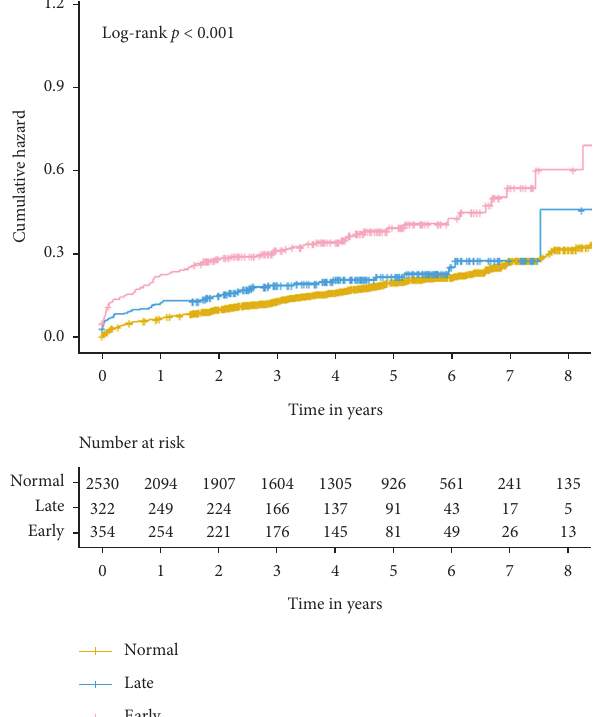
Figure 2: Kaplan–Meier curves for the cumulative probability of mortality stratified according to early CA-AKI, late CA-AKI, and normal. CA-AKI is defined as an increase ≥ 50% or ≥ 0.3mg/dL from